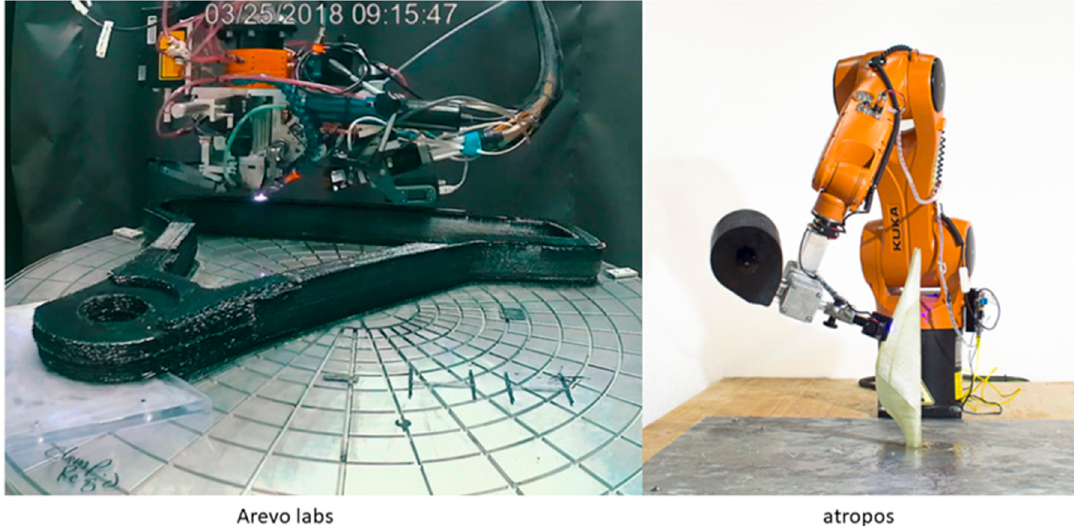
Figure 11. The Arevo labs robotic AM system printing a portion of a bicycle frame ( left ) [71]. Figure 11 . The Arevo labs robotic AM system printing a portion of a bicycle frame (left) [71]. The The Atropos Robot system printing a glass / epoxy turbine blade without a mould for support ( right ) Atropos Robot system printing a glass/epoxy turbine blade without a mould for support (right) [72].